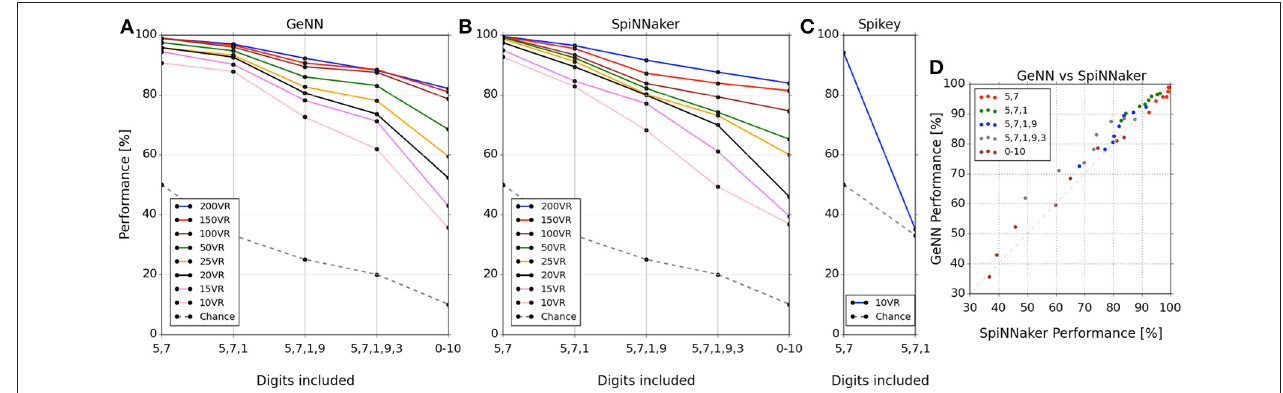
FIGURE 3 | Classifier performance on each platform for combinations of digit selections and number of virtual receptors (VRs). Performance is plotted as percentage correctly classified test samples (A–C) . (D) shows this performance comparatively between SpiNNaker and GeNN across all experiments. Note that the performance is similar across platforms for networks of equal size in spite of the implementation differences. Note that the lines connecting markers are included simply as a visual guide to associate results for the same number of VRs.